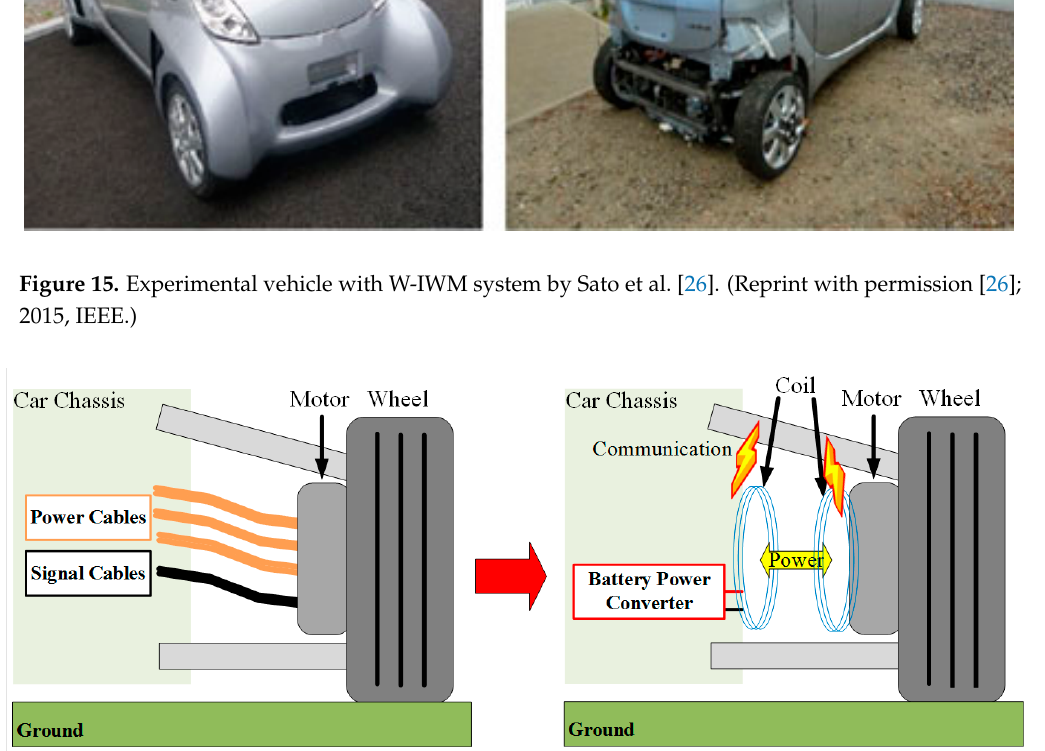
Figure 16. Conventional and wireless IWM. In the wireless setup, coils are used instead of wires to transfer power from battery to the motor. Adapted from [26].